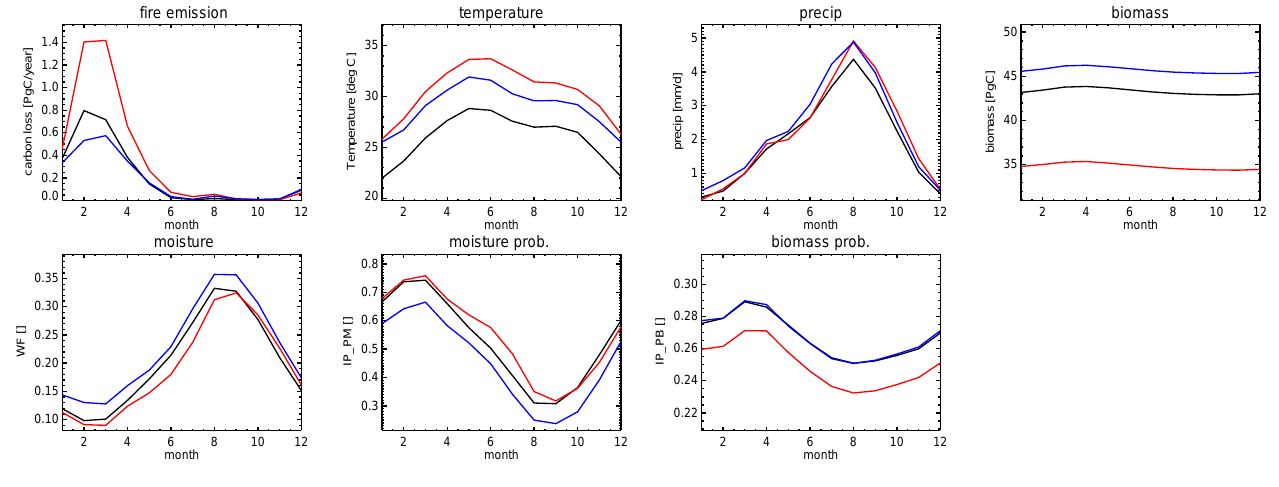
Fig. 12. Similar as Fig. 10 for the region Northern Hemisphere Africa